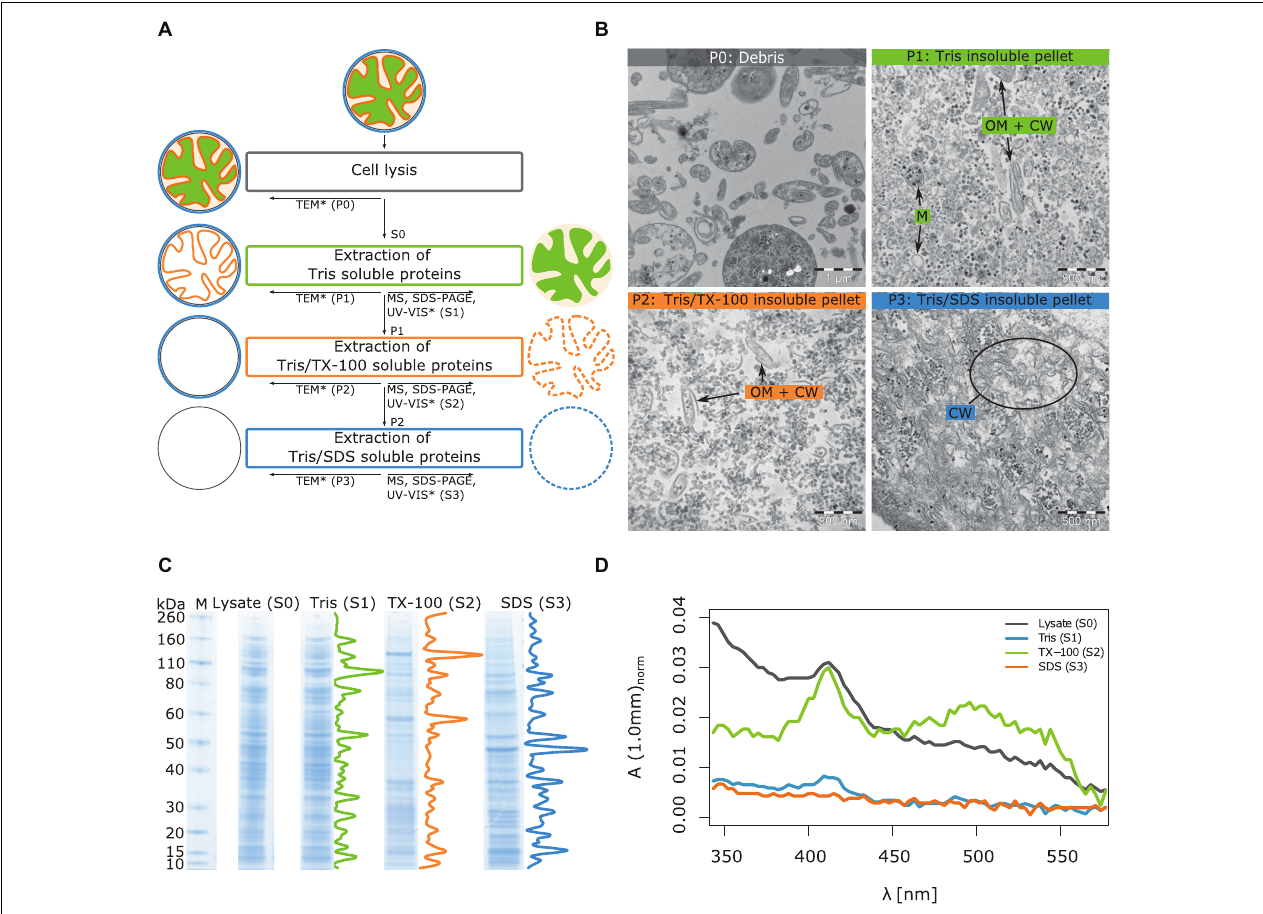
FIGURE 2 | Illustration of workflow for subcellular fractionation by differential solubilization and results from imaging and biochemical analysis of the subcellular fractions. (A) After lysis, unbroken cells and debris are removed by low-speed centrifugation (P0). The Tris-soluble proteins (S1) are separated from the Tris-insoluble pellet (P1) by ultracentrifugation. The Tris/TX-100-soluble proteins (S2) are further separated from the Tris/TX-100-insoluble pellet (P2) by ultracentrifugation. In the last step, Tris/SDS-soluble proteins (S3) are separated from the Tris/SDS-insoluble pellet (P3). Supernatants and pellets were subjected to the indicated analyses: TEM, Transmission Electron Microscopy, MS, LC-MS/MS, Liquid chromatography coupled to tandem-mass-spectrometry, SDS-PAGE, UV-VIS spectroscopy. *Method applied only to T. immobilis . (B) Analysis of T. immobilis pellets P0, P1, P2, and P3 by TEM. OM: outer membrane; CW, cell wall; M, cytoplasmic membrane. (C) Analysis of subcellular fractions (S1, S2, S3) and the total cell lysate (S0) by SDS-PAGE (M: marker with corresponding molecular weights in kDa). Density profiles are shown next to the lanes of the subcellular fractions. The corresponding SDS-PAGE analysis for E. coli is shown in Supplementary Figure 9